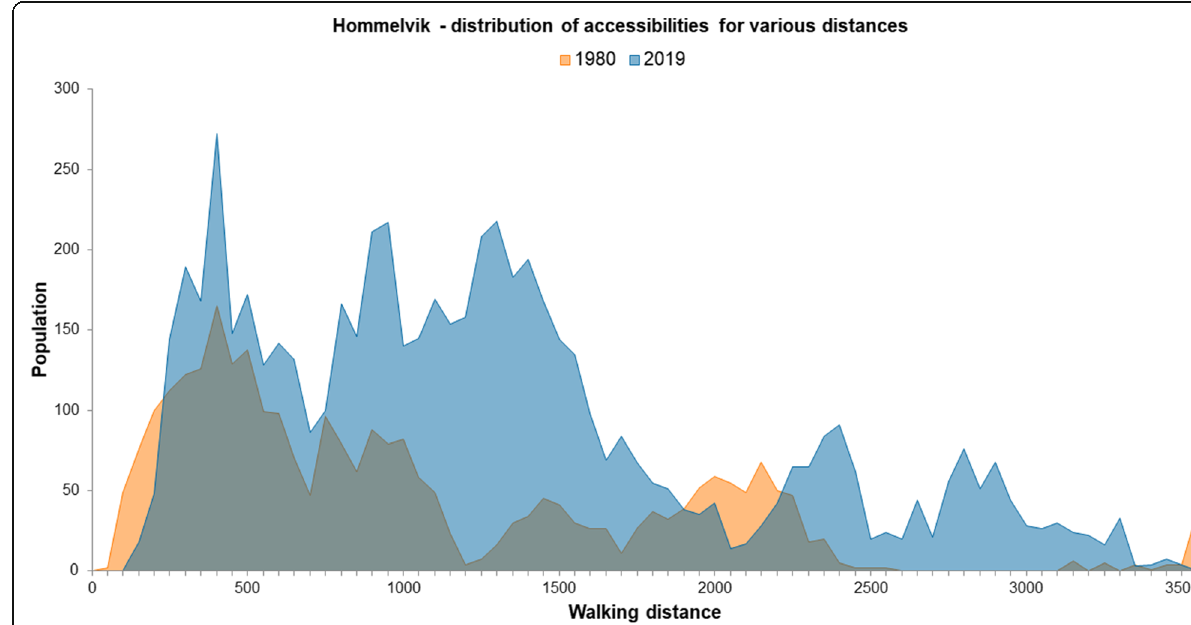
Fig. 7 Accessibility from dwellings to grocery stores in Hommelvik. Population at different distances in 50 m intervals, 1980 (orange) and 2019